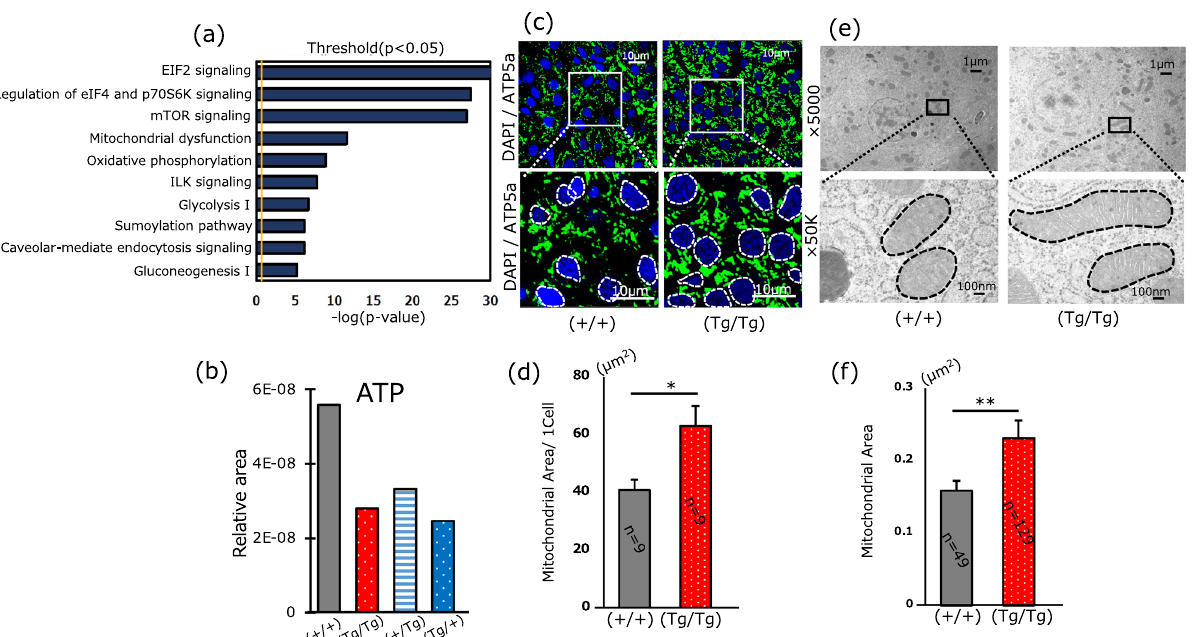
Figure 2. Signal transduction analysis using IPA and transmission electron micrography of mitochondria. ( a ) Top 10 signal transduction networks in the liver tissue from (Tg/Tg) fish based on iTRAQ data. ( b ) The concentration of ATP using five livers from GH homozygous and hemizygous fish and non-transgenic siblings. Bars represent the mean values for five samples. Five livers were pooled as one sample. Relative area = Peak area of the target sample/[Area value of internal standard × Sample weight (mg)]. ( c ) Mitochondrial observation by immunofluorescence against ATP5a (Green) and DAPI (Blue) [(+/+), (Tg/Tg): each n = 3). ( d ) Signal intensity corresponding to ATP5a. Three fields from one slide were randomly selected, and fluorescence was quantified. The area was divided by the number of nucleoli. Statistical significance was obtained using Student’s t -test. ( e ) Transmission electron micrograph of mitochondria; the black square (× 5000) was magnified 50,000 times. [(+/+), (Tg/Tg): each n = 3).The mitochondrial outline is defined by dotted lines, and ( f ) the area was measured using Image J. Statistical significance was obtained using Student’s t -test.